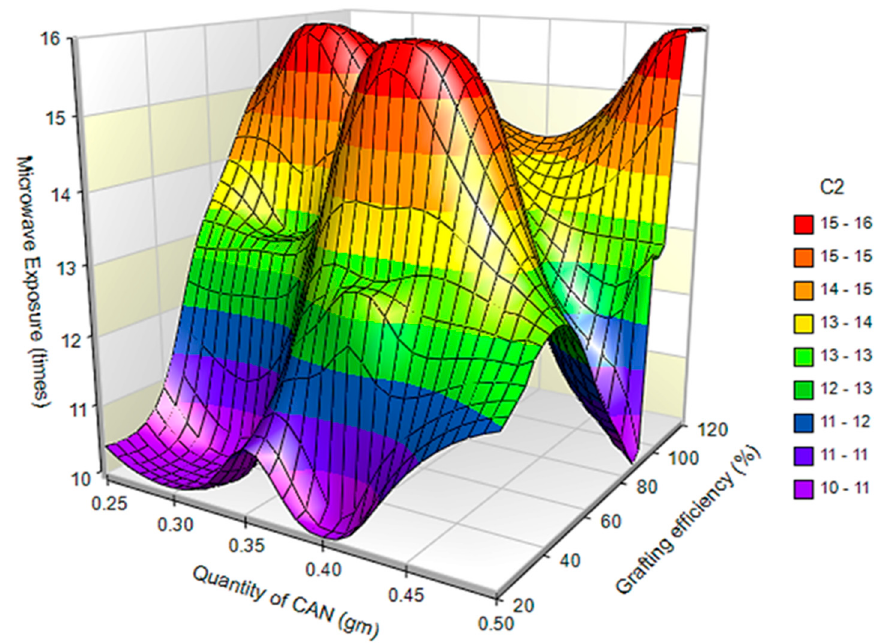
Figure 2. Surface plot for effect of independent variables on grafting efficiency .